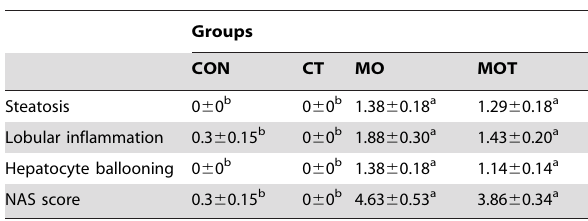
Table 3. Maternal liver scoring.